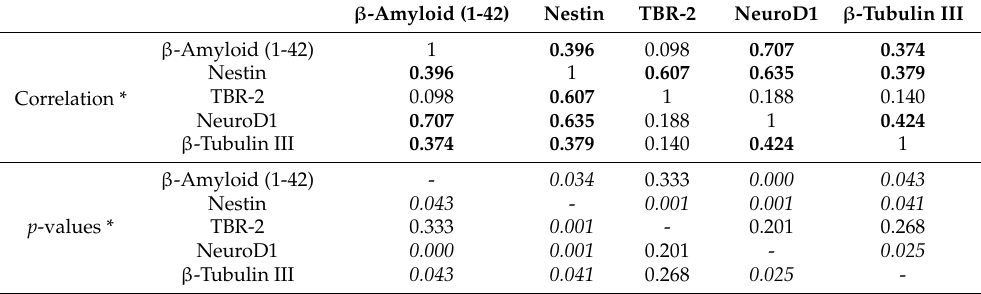
Table 2. Correlations matrix among all the variables included in the